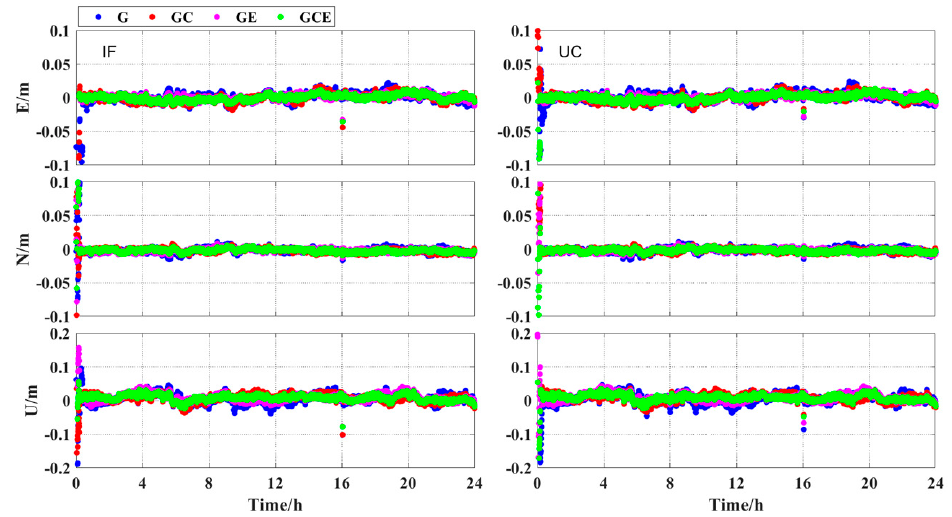
Figure 11. The RMS results of position differences of the IF model ( left ) and UDUC model ( right ) G/GE/GC/GCE kinematic PPP-AR on DOY 301, 2021, for the YEL2 station.